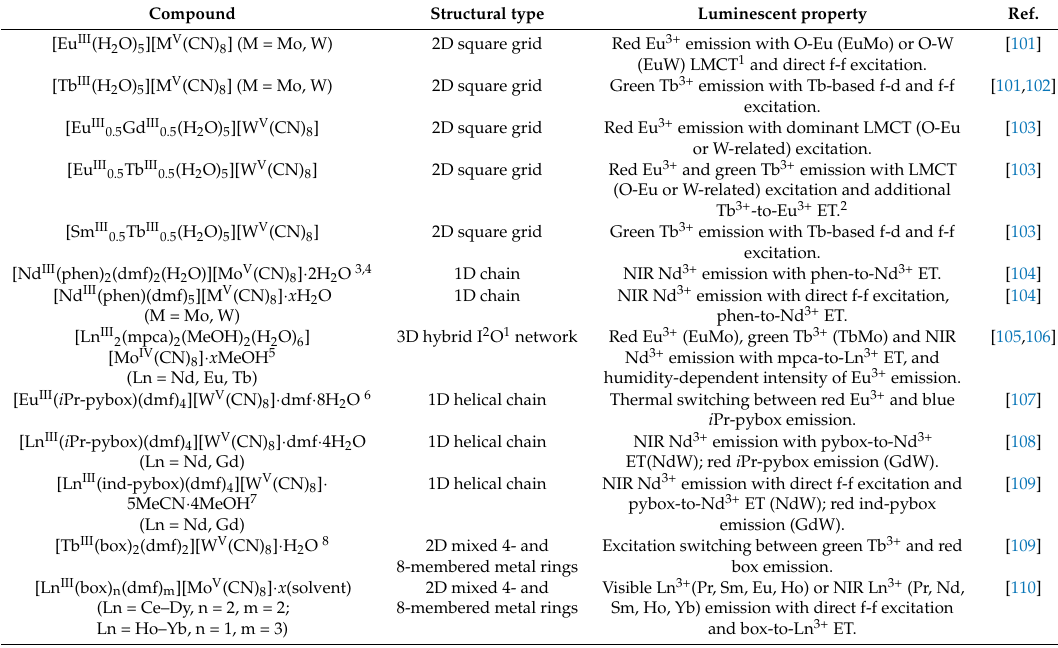
2D mixed 4- and Excitation switching between green Tb 3+ and red 8-membered metal rings box emission. 2D mixed 4- and Visible Ln 3+ (Pr, Sm, Eu, Ho) or NIR Ln 3+ (Pr, Nd, 8-membered metal rings Sm, Ho, Yb) emission with direct f-f excitation and box-to-Ln 3+